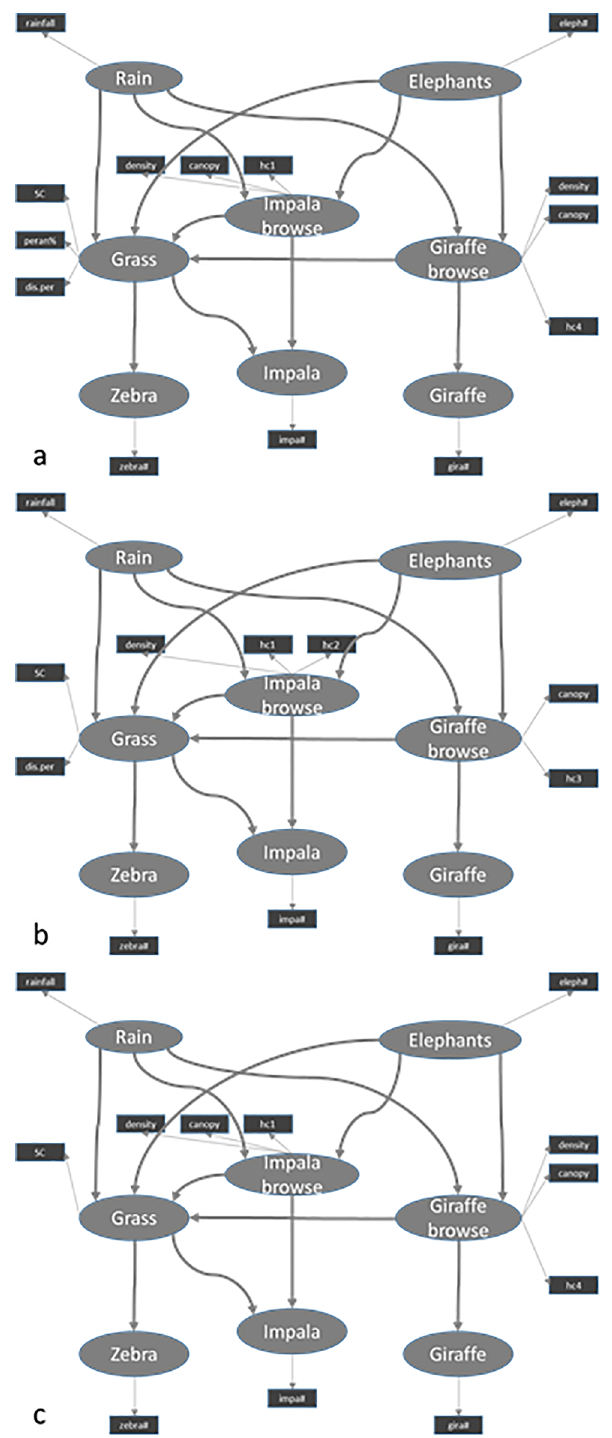
Fig 2. The final path models. The final path model for (a) Balule Game Reserve (Goodness of fit = 0.56), (b) Kapama Game Reserve (Goodness of fit = 0.64) and (c) Sabi Sand Wildtuin (Goodness of fit = 0.64) after removing bad manifest variables. Circles show latent variables and squares manifest variables. Arrows between latent variables indicate correlations and arrows toward manifest variables show which variables describe the latent variable.